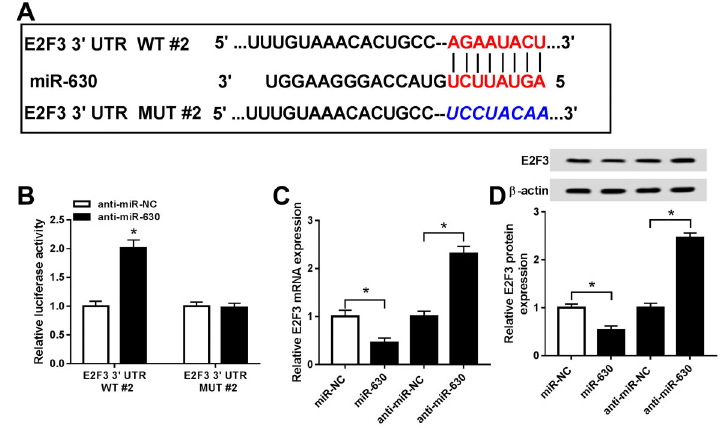
Figure 5. A , The presumptive binding sites between miR-630 and E2F3 were predicted by Targetscan. B , Dual-luciferase reporter system was applied for assaying the luciferase activity of SRA01/04 cells co-transfected with E2F3 3 0 UTR WT#2 or E2F3 3 0 UTR MUT#2 and anti-miR-630 or anti-miR-NC. C and D , qRT-PCR and western blot were carried out for detecting the expression of E2F3 mRNA and protein in SRA01/04 cells transfected with miR-NC, miR-630, anti-miR-NC, and anti-miR-630. Data are reported as means ± SD. *P o 0.05. ( t -test or ANOVA). WT: wild-type; MUT: mutant-type; NC: negative control.